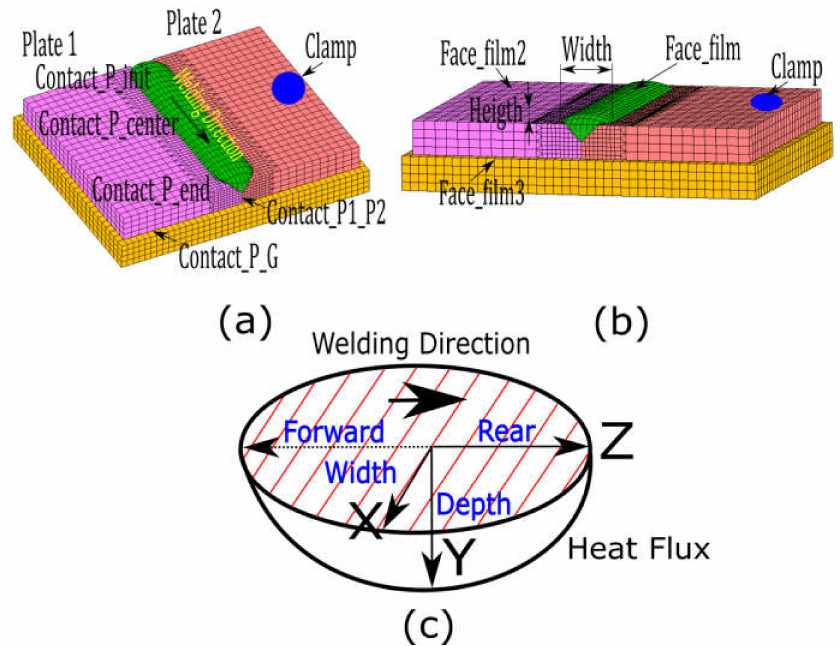
Figure 6. ( a ) Thermal contacts proposed in the FE model to solve the conduction phenomena; ( b ) Thermal convection coefficients proposed in the FE model to solve the convection phenomena; and, ( c ) Double Ellipsoidal Weld Flux showing the forward_length, rear_length, width and